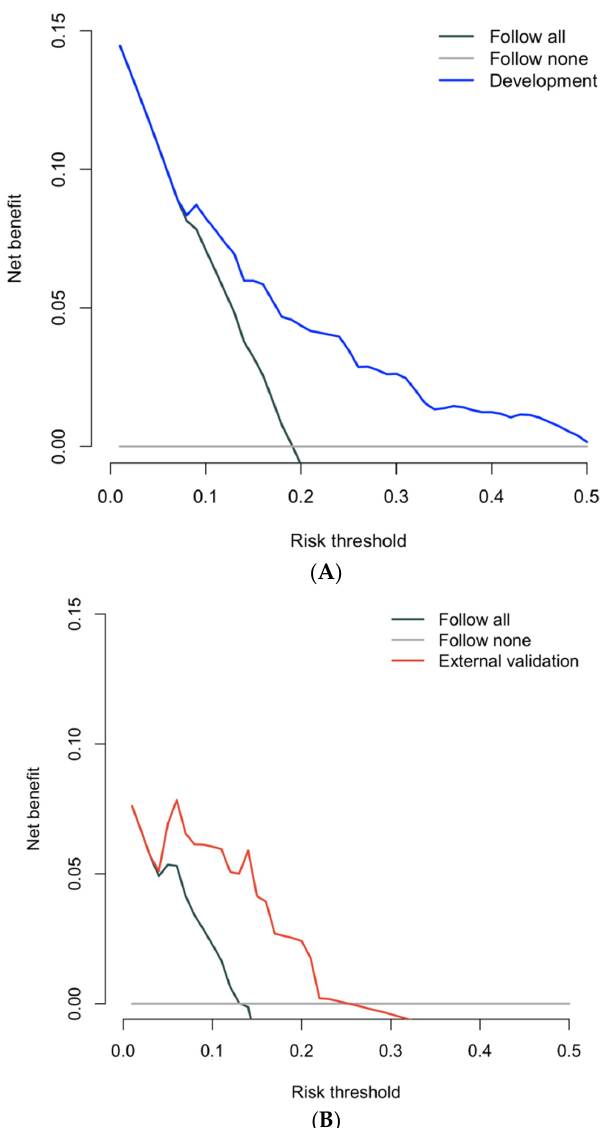
Figure 4. Decision curve analyses at 4 years in development ( A ) and external validation ( B ).